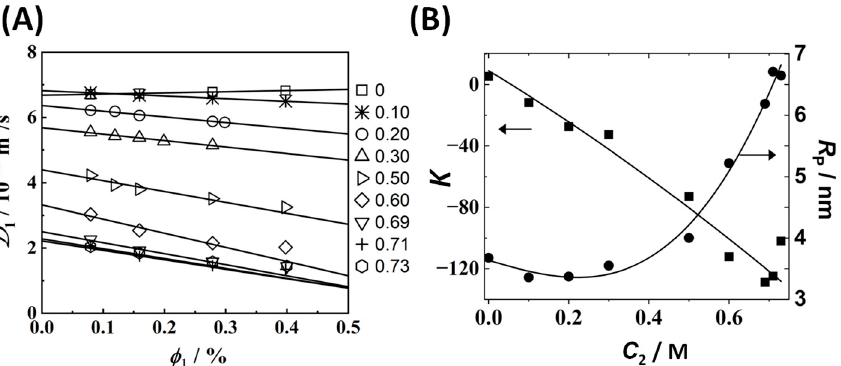
Figure 2. ( A ) DLS diffusion coefficient, D 1 , as a function of tyloxapol volume fraction, φ 1 , at several MgSO 4 concentrations, C 2 /M (listed on the right) and 25 ◦ C. Solid lines are linear fits through the data. The lines associated with C 2 ≥ 0.50 M were obtained without employing the highest concentration of φ 1 = 0.4% due to curvature. Values of D 1 with uncertainties are reported in Supplementary Materials Section S1. ( B ) Micelle hydrodynamic radius, R P ( ● ), and slope, K ( ■ ), as a function of salt concentration. Curves are eye guides.